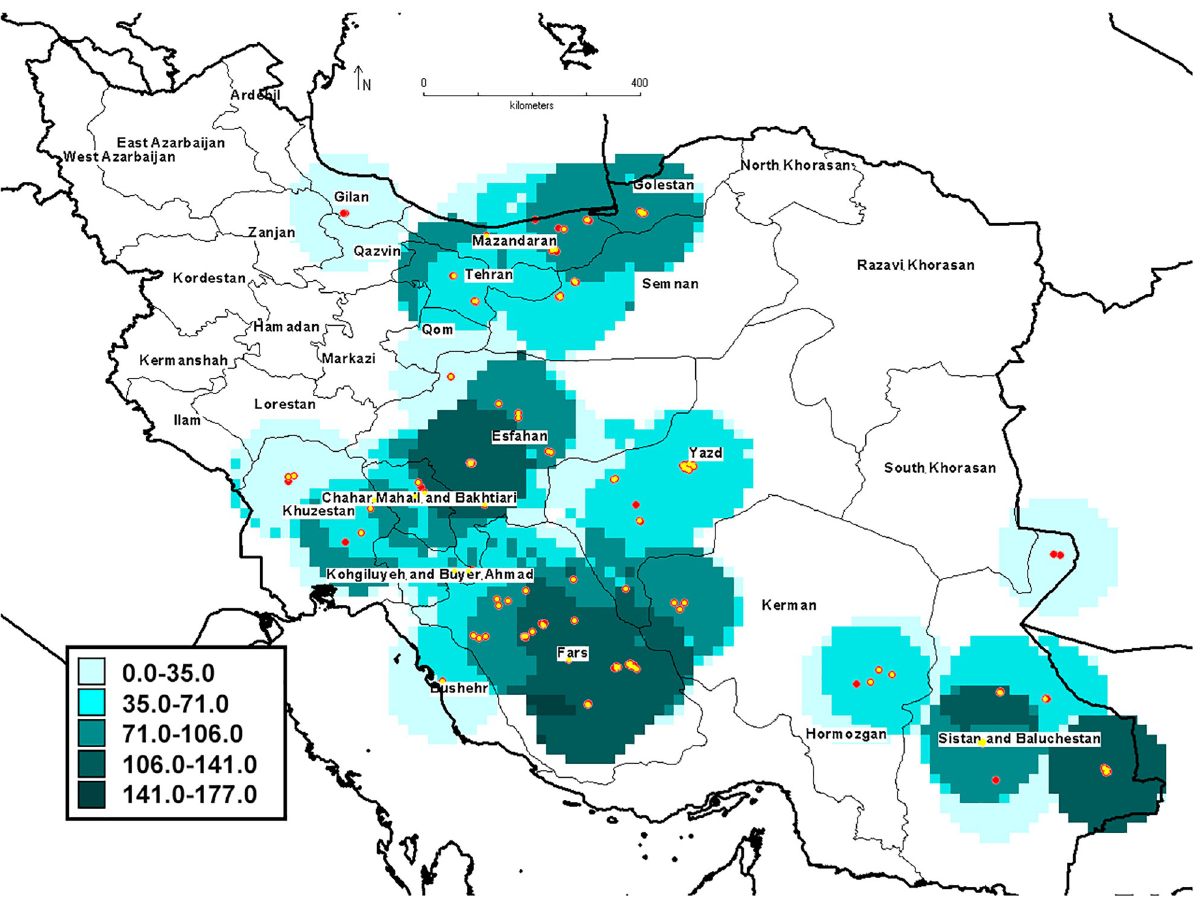
Fig 2. The geographical distribution map of pomegranate genotypes evaluated in terms of yield (CV).